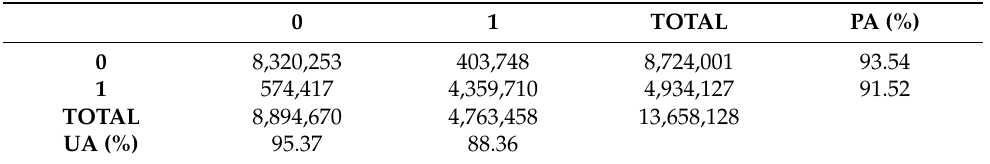
Table 7. Error matrix for San Lazzaro. 0 = not green; 1 = green. Rows = visual analysis; columns = NDVI + Topographic DB. UA = user’s accuracy; PA = producer’s